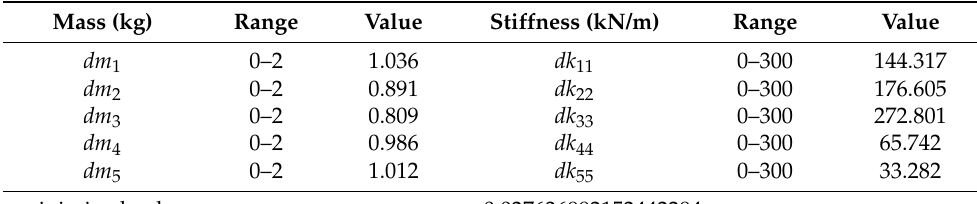
Figure 21. The goal of this modification was to assign the two vibration modes listed in Table 3. The ranges of the added masses and stiffness were 0~2 kg and 0~300 kN/m, respectively. By solving the optimization Equation (24) using the genetic algorithm, the optimized values of the substructures and the minimized values were solved and expressed in Table 21: Table 21. Parameters of added masses and stiffness of substructures. Mass (kg)